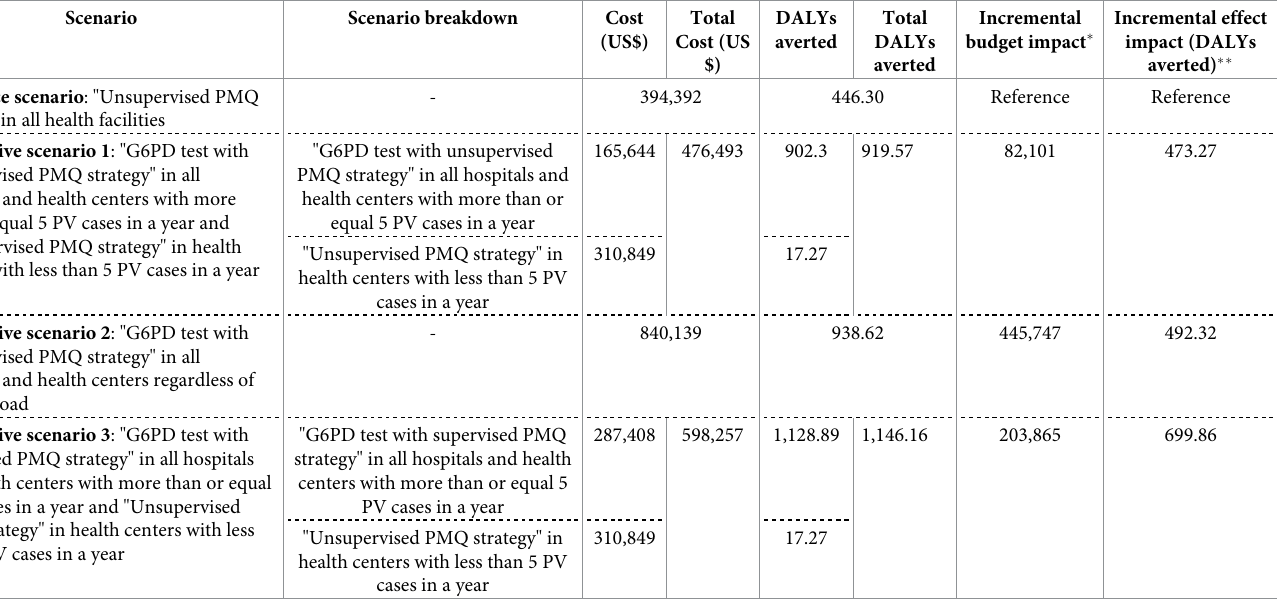
Table 6. Budget impact analysis for nation-wide scale-up of different scenarios plausible to Laos’